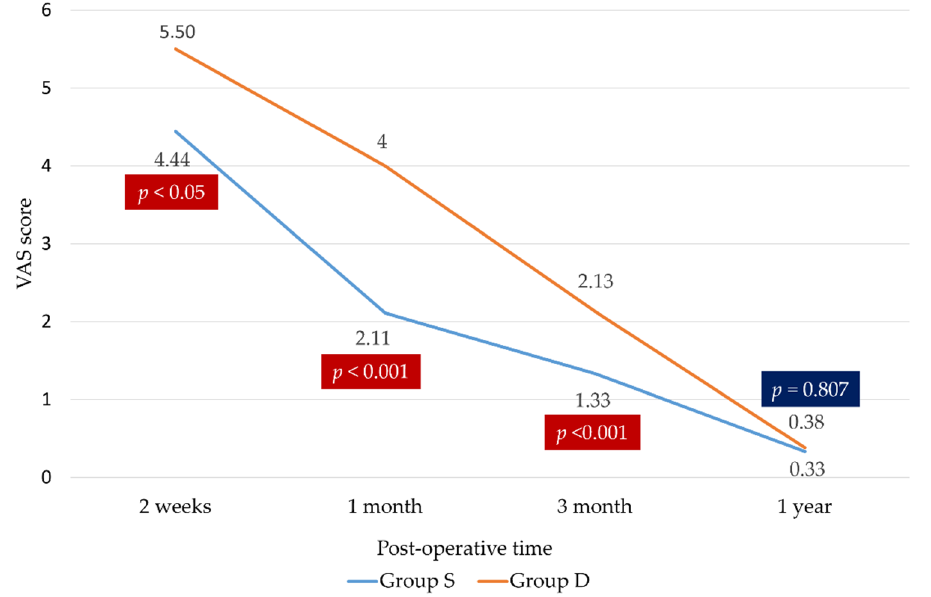
Figure 5. Visual analogue scale (VAS).